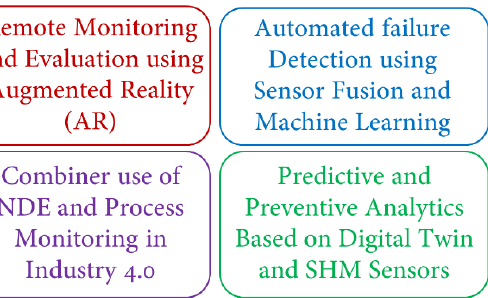
Figure 9. Core areas for digital transformation in the field of NDE as defined for Fraunhofer IKTS (After [11]).